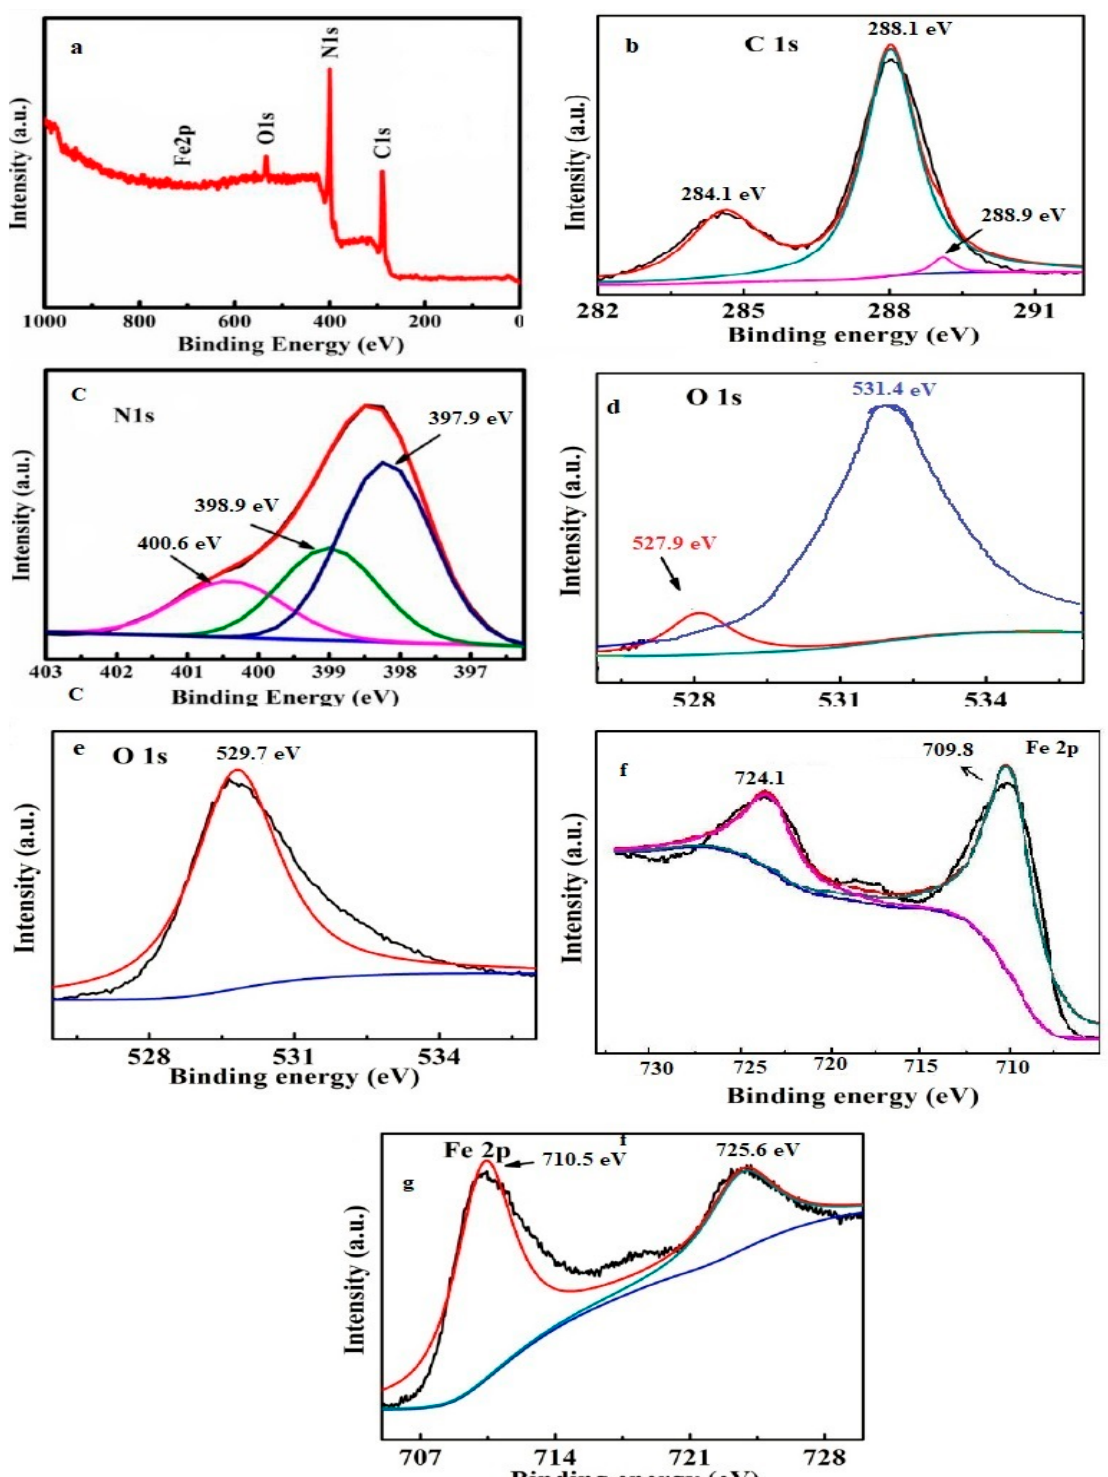
Figure 3. XPS spectra of clean α -Fe 2 O 3 /g-C 3 N 4 ( a ); C 1s ( b ); N 1s ( c ); O 1s ( d ); O 1s α -Fe 2 O 3 ( e ); Fe 2p ( f ); and Fe 2p α -Fe 2 O 3 ( g ).